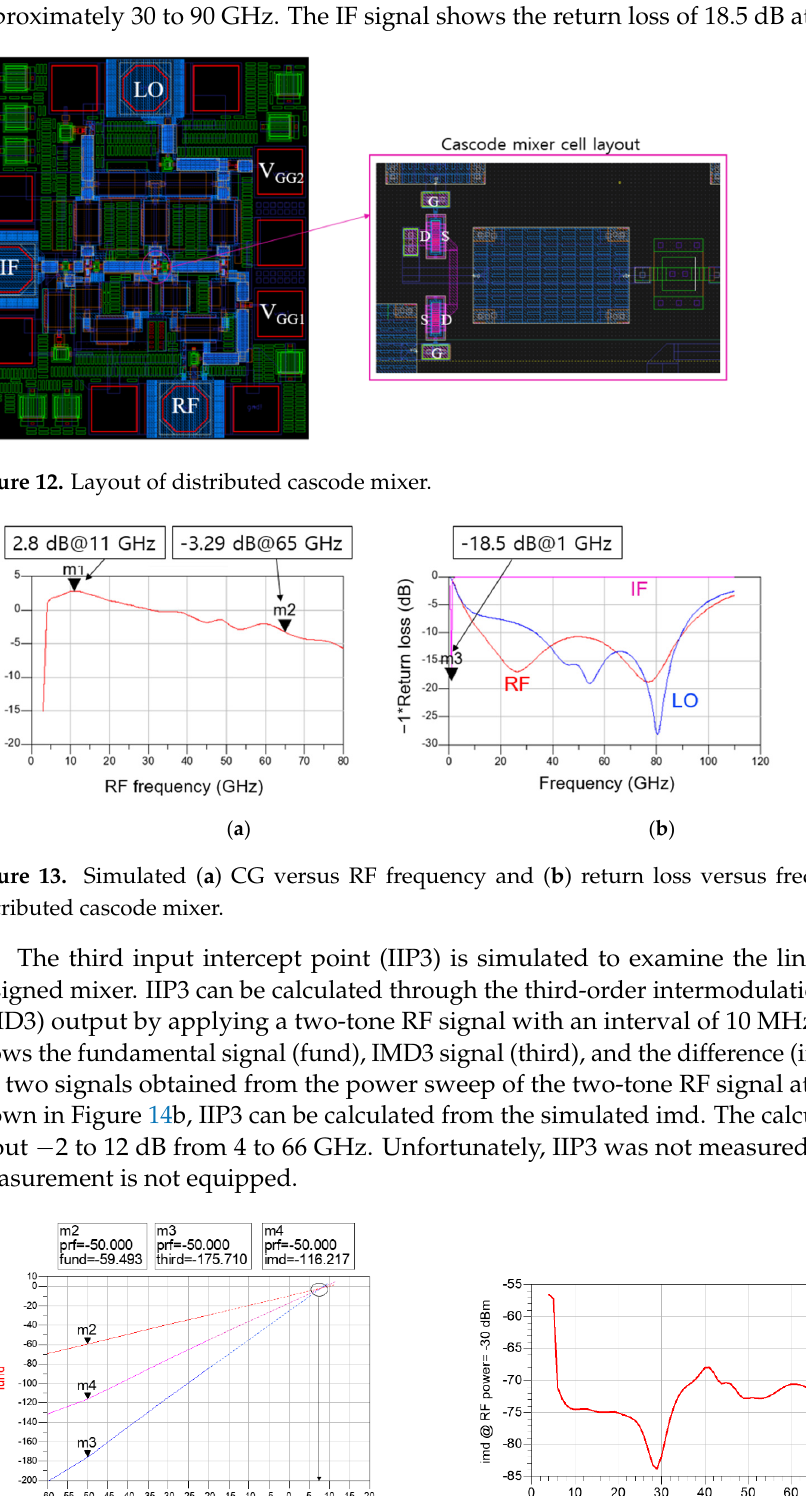
Figure 14. ( a ) Fundamental signal (fund), IMD3 signal (third) and the difference between the two signals (imd) according to the power sweep of the two-tone RF signal at 20 GHz ( b ) simulated imd according to RF Frequency (RF power = −30